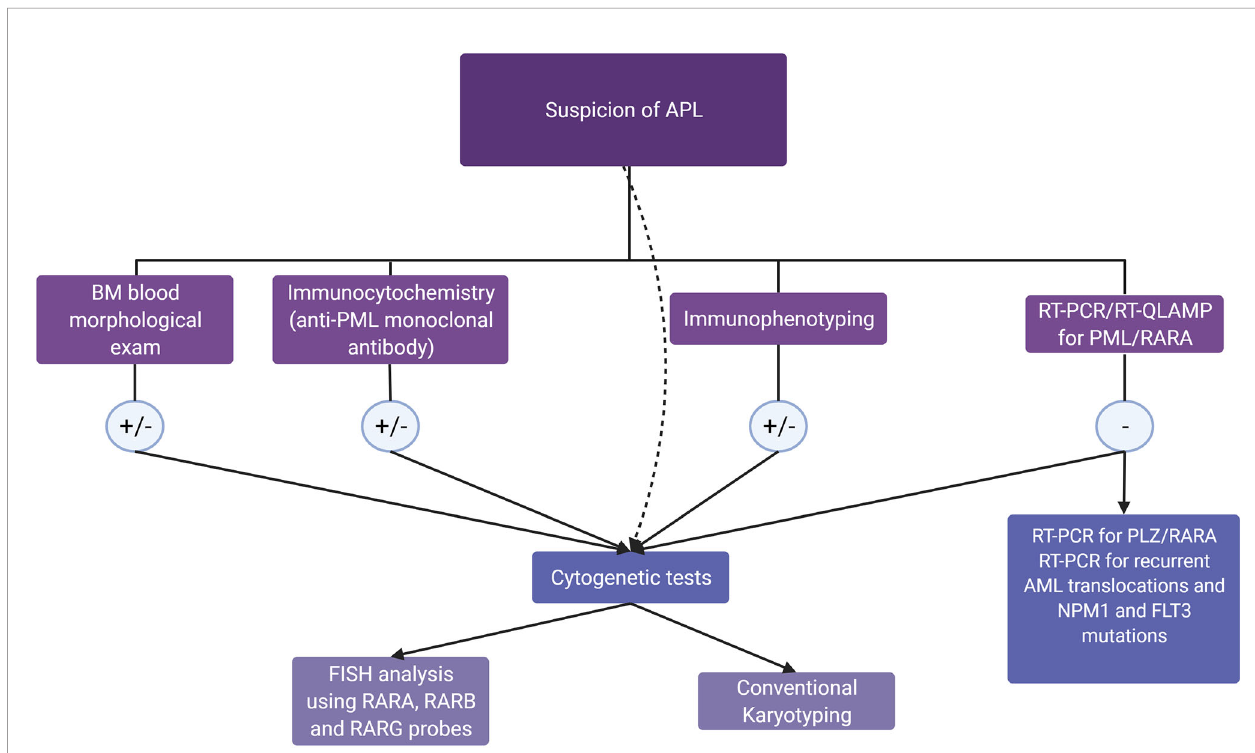
FIGURE 2 | Diagnostic algorithm in the suspicion of acute promyelocytic leukemia (APL) and APL-like acute myeloid leukemias. In patients with morphologic, immunophenotypic, or clinical features raising a suspicion of APL, the guidelines (15) recommend molecular genotyping, which can con fi rm APL diagnosis in a few hours. If the PML/RARA rearrangement is absent, RT-PCR for recurrent translocations and for PLZF/RARA rearrangement, together with NPM1 and FLT3 mutation testing, should be performed. In all cases, cytogenetic tests, including FISH, allow the diagnostic assessment for RARX rearrangements in 1 to 2 days, while conventional karyotyping will detect karyotype abnormalities in 5 – 7 days, as recommended by ELN 2017